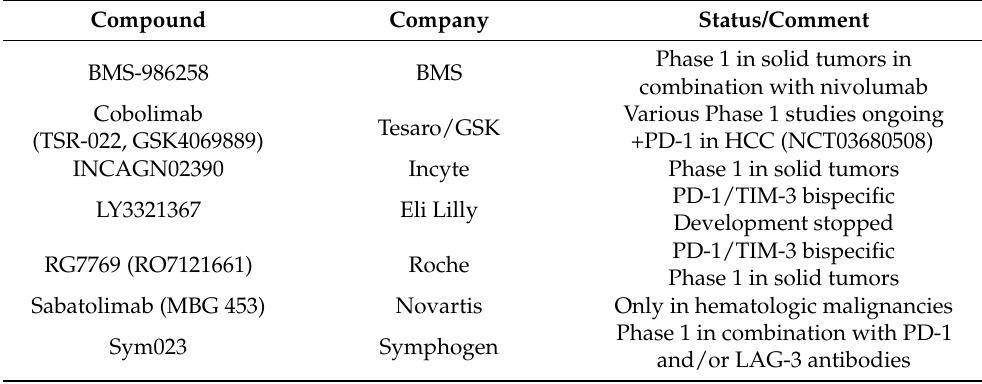
Table 3. TIM-3 inhibitors in clinical